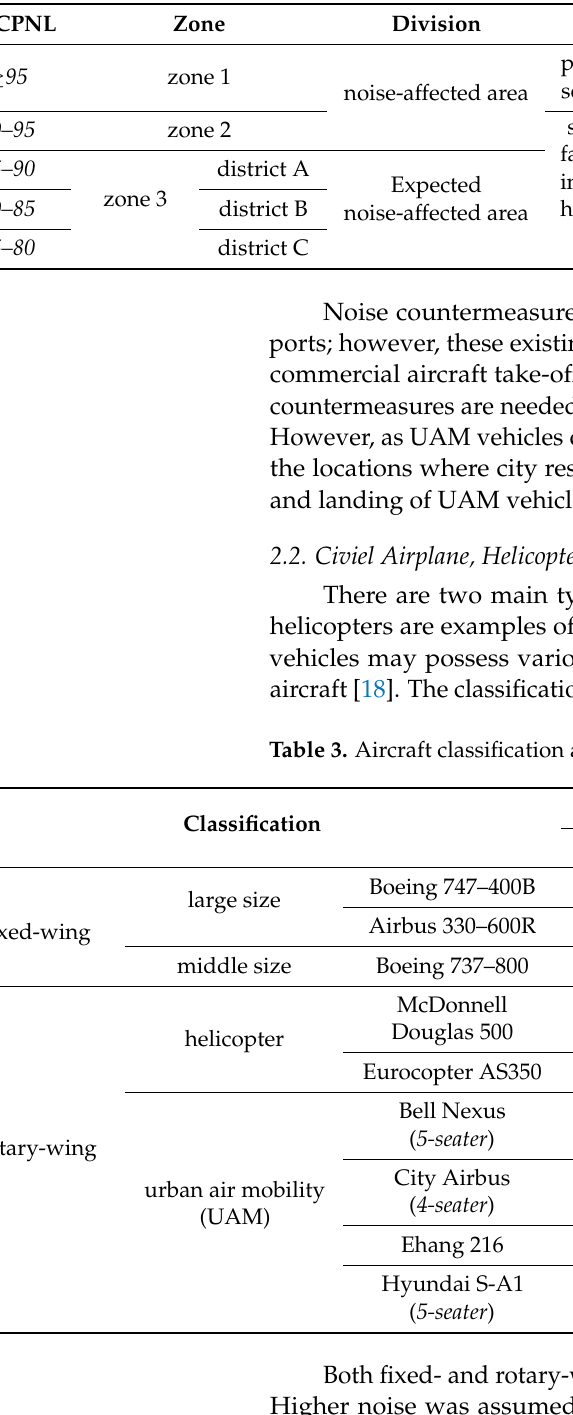
Table 2. Noise classification and countermeasures in the vicinity of Korean airports [17].